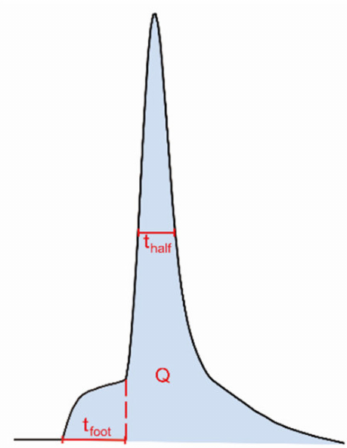
Figure 3. Illustration of di ff erent dynamic parameters used for exocytotic peak analysis from single-cell amperometry, including half peak width (t half ) and foot width (t foot ). The number of molecules (N) can be calculated using Faraday’s law, N = Q / nF; Q, time integral of the peak; n , number of electrons being transferred in the oxidation reaction (2 electrons for oxidation of catecholamines); F, Faraday